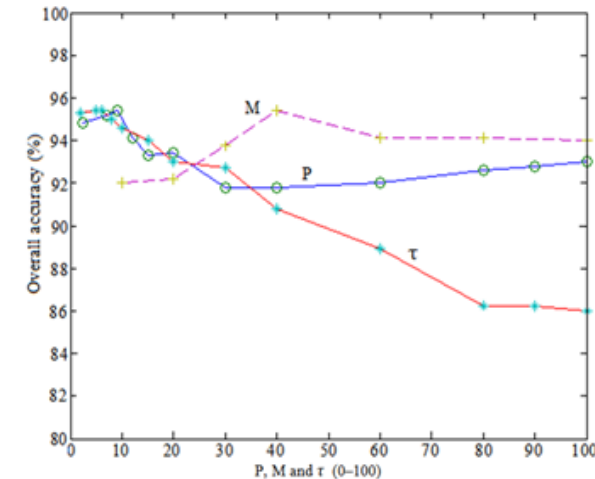
Figure 3. The sensitivity analysis of parameters M, P and . 𝛿𝛿